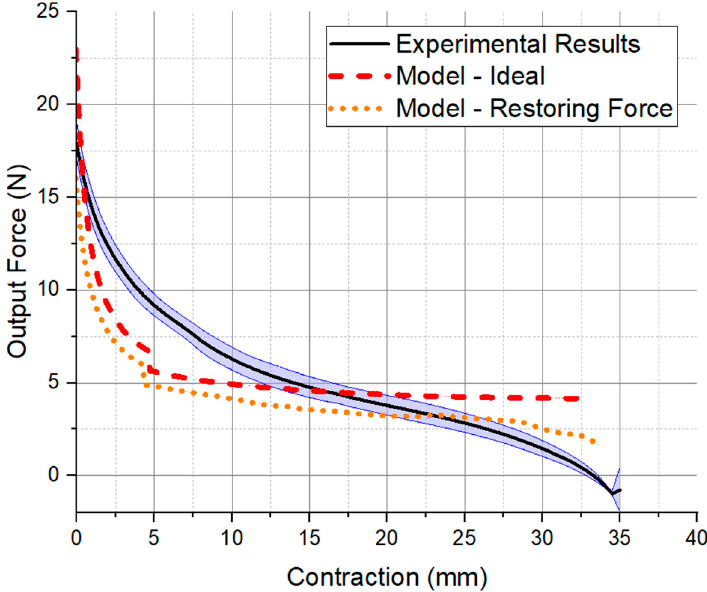
Figure 6. Force-contraction profile of actuator from the average of experimentally measured results ( n = 2 actuators, two trials each) compared with the virtual-work based model after a scaling factor of 0.48 and discarding the first 2% of the model’s contraction. The ideal model is as presented in Equation (1), while the restoring force curve is the result of subtracting the experimental average of the restoring force of the actuator (see Supplementary Materials) from the ideal model.